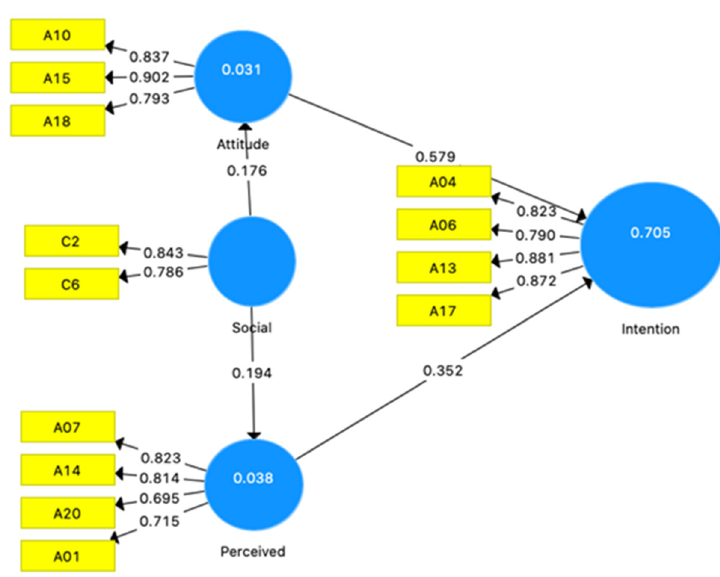
Figure 4. PLS Model for model 3 (women).